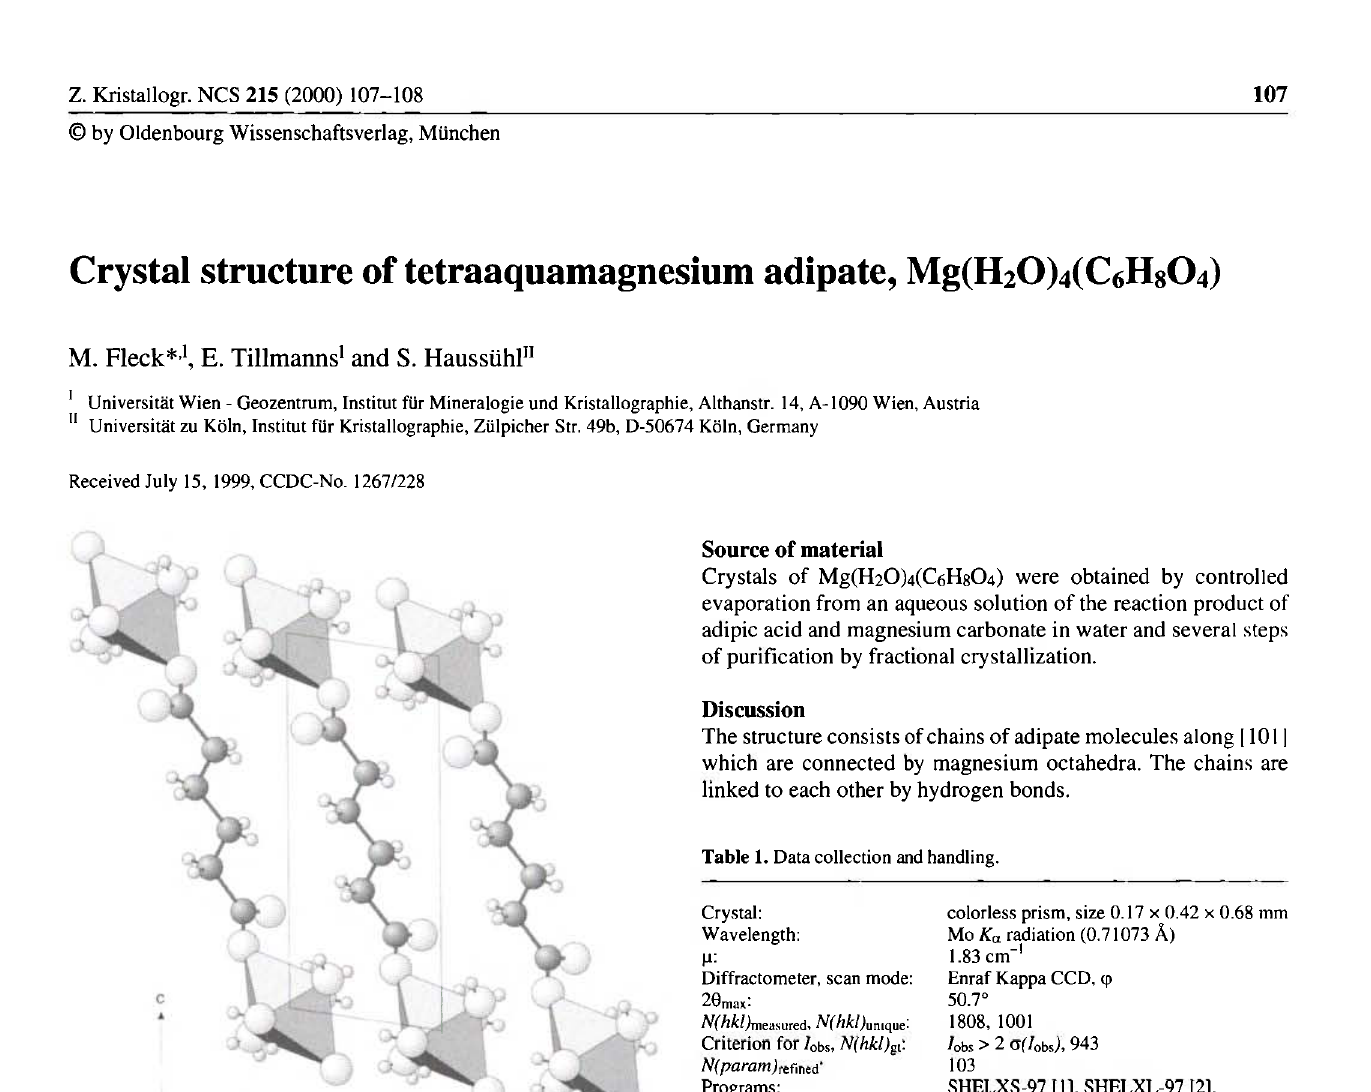
Table 2. Atomic coordinates and displacement parameters (in A ).